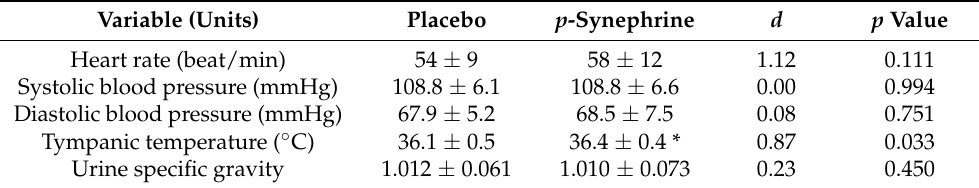
Table 2. Cardiovascular variables and tympanic temperature at rest and urine specific gravity after the ingestion of 3 mg/kg of p -synephrine or a placebo. Data are presented as mean ± standard deviations (SD). Variable (Units) Placebo p -Synephrine d p Value Heart rate (beat/min) 54 ± 9 58 ± 12 1.12 0.111 Systolic blood pressure (mmHg) 108.8 ± 6.1 Diastolic blood pressure